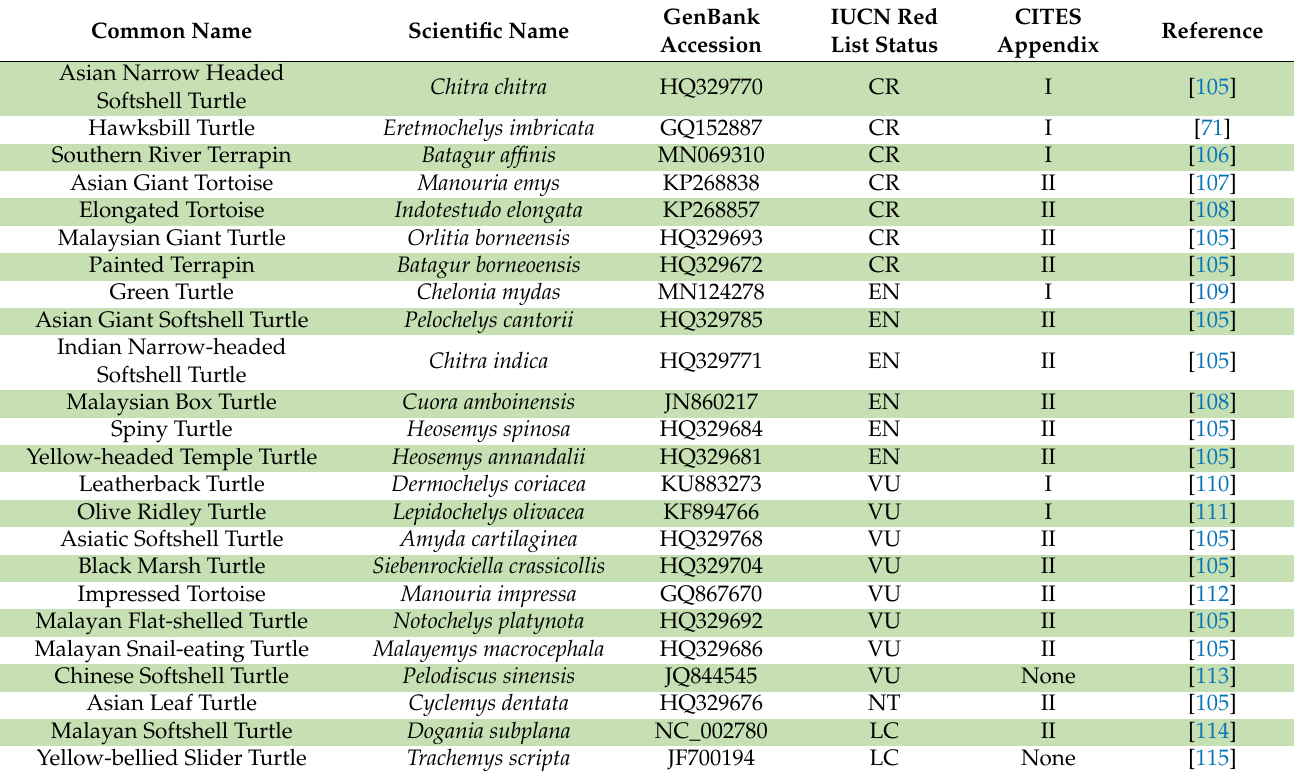
Table 3. Checklist of Turtle Species in Malaysia